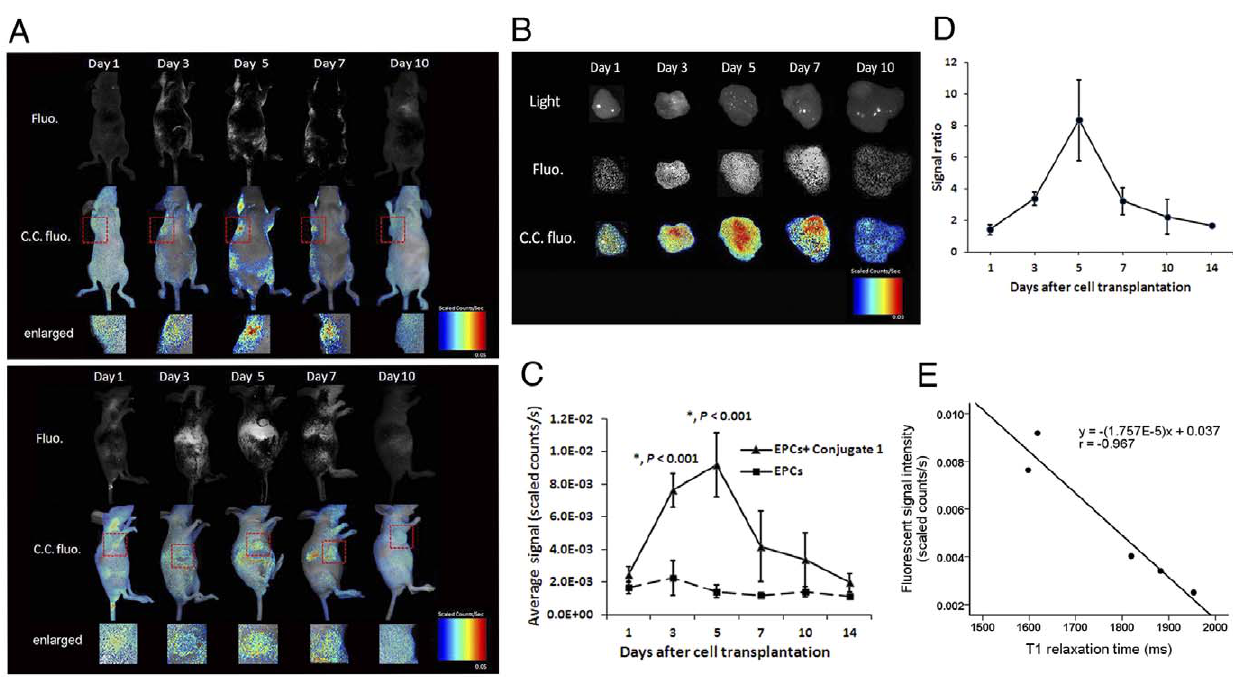
Figure 3. Enhancement of fluorescence intensity at the tumor area in optical imaging. (A) Near infrared fluorescence images and color- coded fluorescence images of decubitus and lateral position of a mouse post transplantation show peak signal intensity appeared at day 5 (Fluo, fluorescence; C.C. fluo, color-coded fluorescence). (B) A strong Cy5.5 fluorescence emission was detected in the tumor tissue 5 days after EPC transplantation and remained until day 7. (C) The peak value of average fluorescent signal intensity was measured at day 5 with (9. 18 6 1.98) 6 10 2 3 scaled counts/s. Signal intensity changes from day 3 to day 5 in group 1 were statistically significant ( p , 0.001, n =3). (D) The signal ratio of tumors (signal ratio was calculated as signal intensities of the tumor with labeled EPCs over the control tumor with unlabeled EPCs) reached the maximum of 8.34 6 2.55 at day 5. (E) A linear correlation between averaged fluorescent signal intensity and intratumoral T 1 relaxation time was observed ( r = 2 0.967, p ,